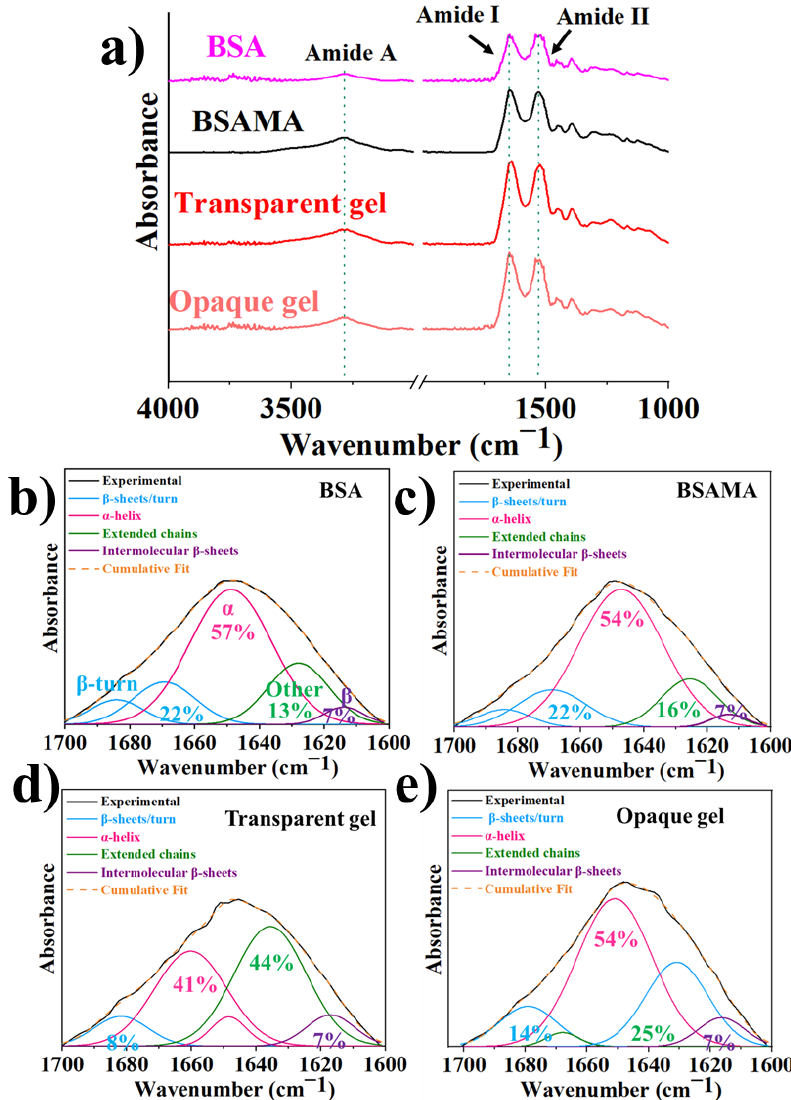
Figure 2. ( a ) Fourier-transform infrared spectroscopy (FTIR) analysis of BSA, BSA MA, along with BSAMA transparent and opaque gels. Normalized ATR-FTIR spectra of ( b ) native BSA, ( c ) BSAMA, ( d ) transparent BSAMA gel, and ( e ) opaque BSAMA gel.